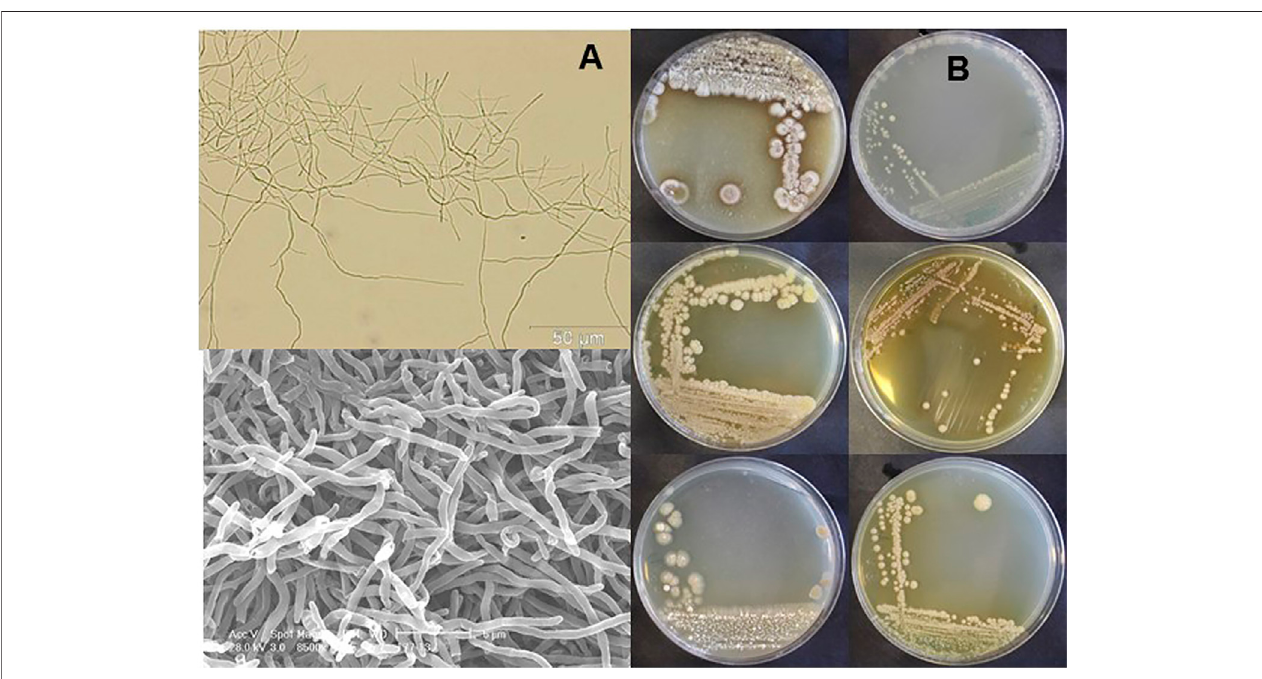
FIGURE 1 | Mycelial morphology (A) and macromorphology (B) of Kitasatospora sp. SUK42. (A) Scanning electron (top) and bright fi eld microscope images (bottom) of ISP2-grown Kitasatospora sp. SUK42 substrate mycelium. (B) Plates of Kitasatospora sp. SUK42 gown on ISP-2 (top) , ISP-3, ISP-4 (left hand column) and ISP-4 (top) , ISP-5, ISP6 (right hand column)